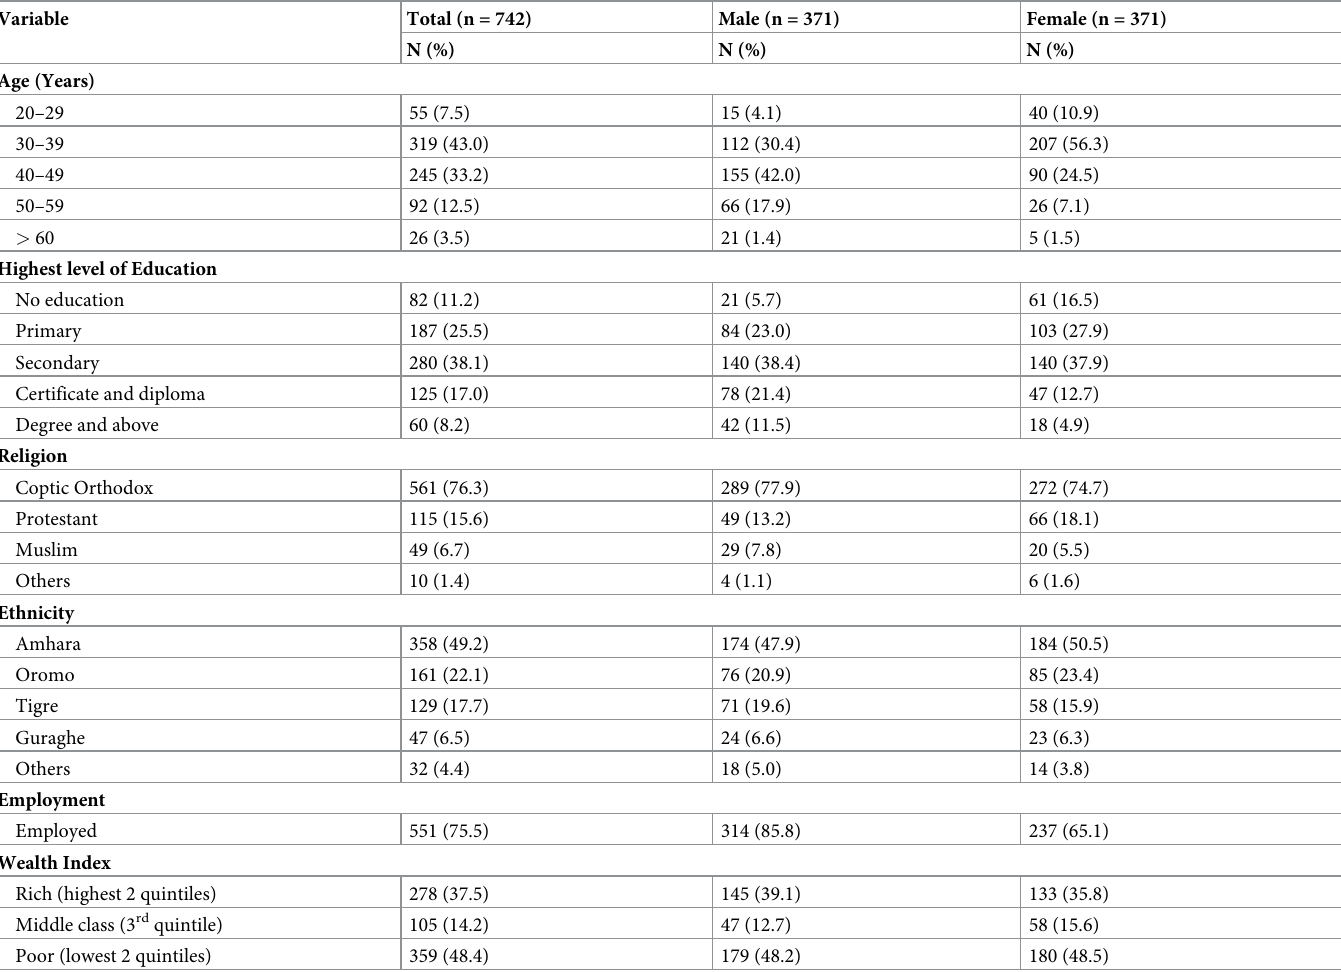
Table 1. Socio-demographic characteristics of participants by